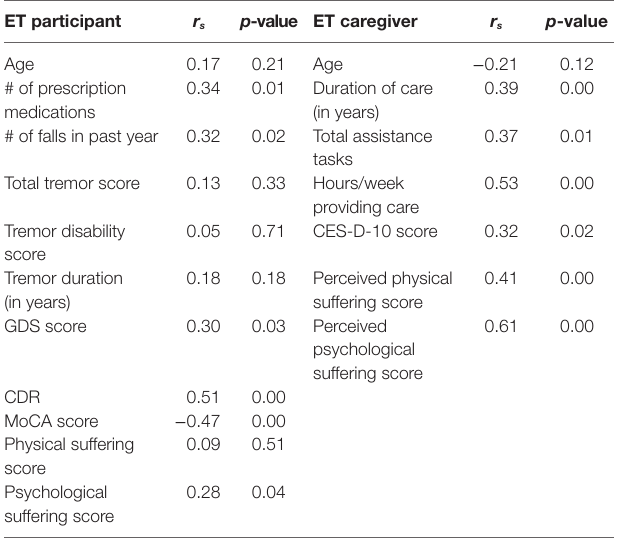
TaBle 4 | Spearman’s correlations with ZBI-12